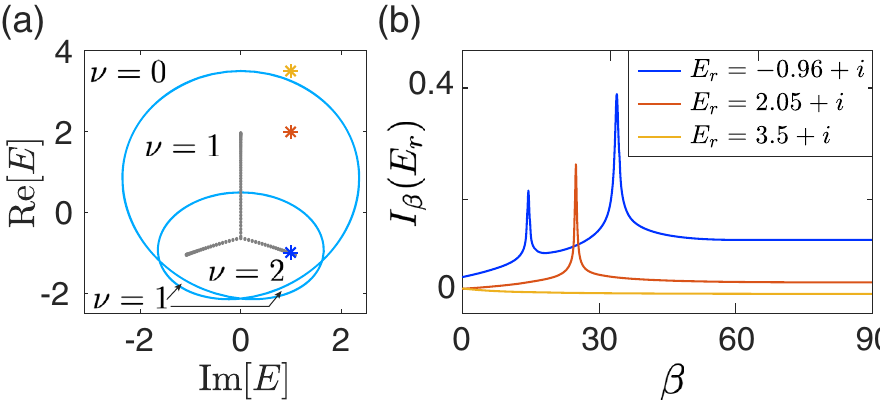
Fig. 1 The generic Hatano-Nelson model with different spectral winding numbers. a Spectra under periodic (cyan loops) and open (gray dots) boundary conditions, of the model [Eq. (3)] with hopping ranges up to 2. The spectral winding number for each different regime is indicated on the panel. b The quantity I β ( E r ) = ∑ n ∣ 1/( E n ( β ) − E r ) ∣ , where E r is the reference energy marked in ( a ) with the same color (yellow, red, and blue), and E n ( β ) is the n th eigenenergy of the system with the hoppings across the boundary multiplied by e − β . I β ( E r ) diverges exactly ν times when E r sits in a region of spectral winding ν . Parameters are set at t 1 = 1, t − 1 = 0.5, t 2 = 2, and t − 2 = 0, with N =